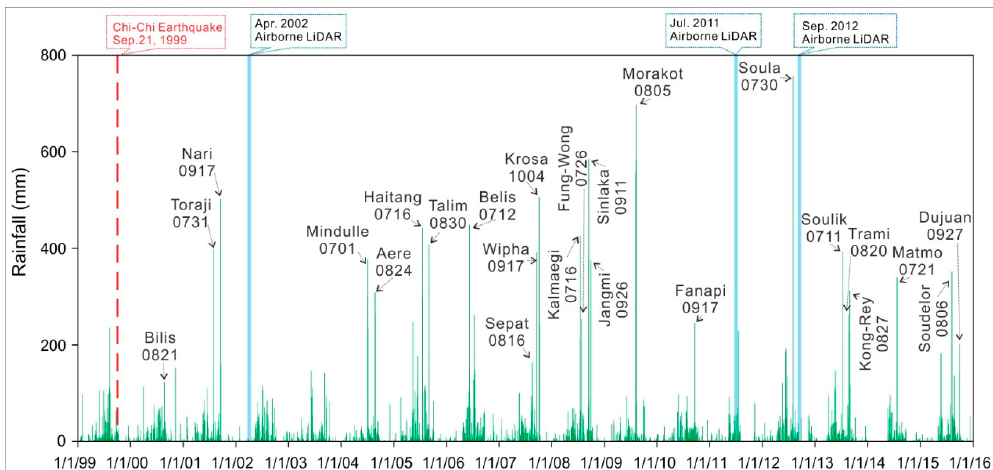
Figure 2. The green histograms show the rainfall distribution data recorded by the Tsaoling rain gauge station in the Tsaoling landslide area from 1999 to 2015 with typhoon and torrential rain indicated. The red dashed line is when the Mw 7.6 Chi-Chi earthquake occurred, and the blue solid lines indicate the multi-period ALS data utilized in the study.